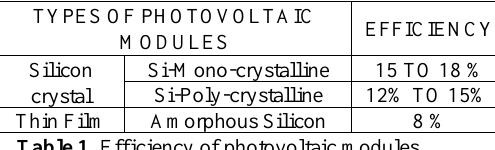
Table 1. Efficiency of photovoltaic